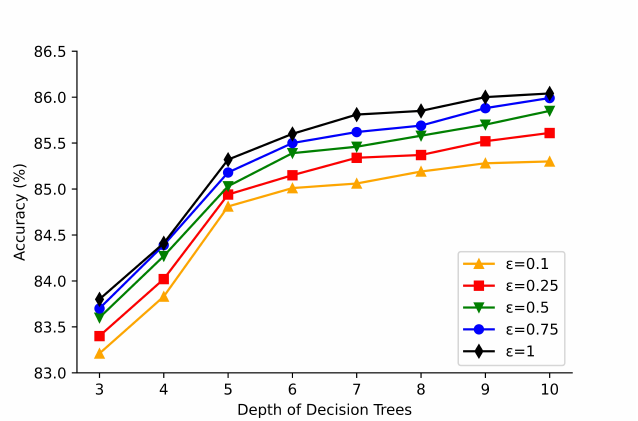
Figure 2. Variation of classification accuracy with tree depth for Adult dataset.